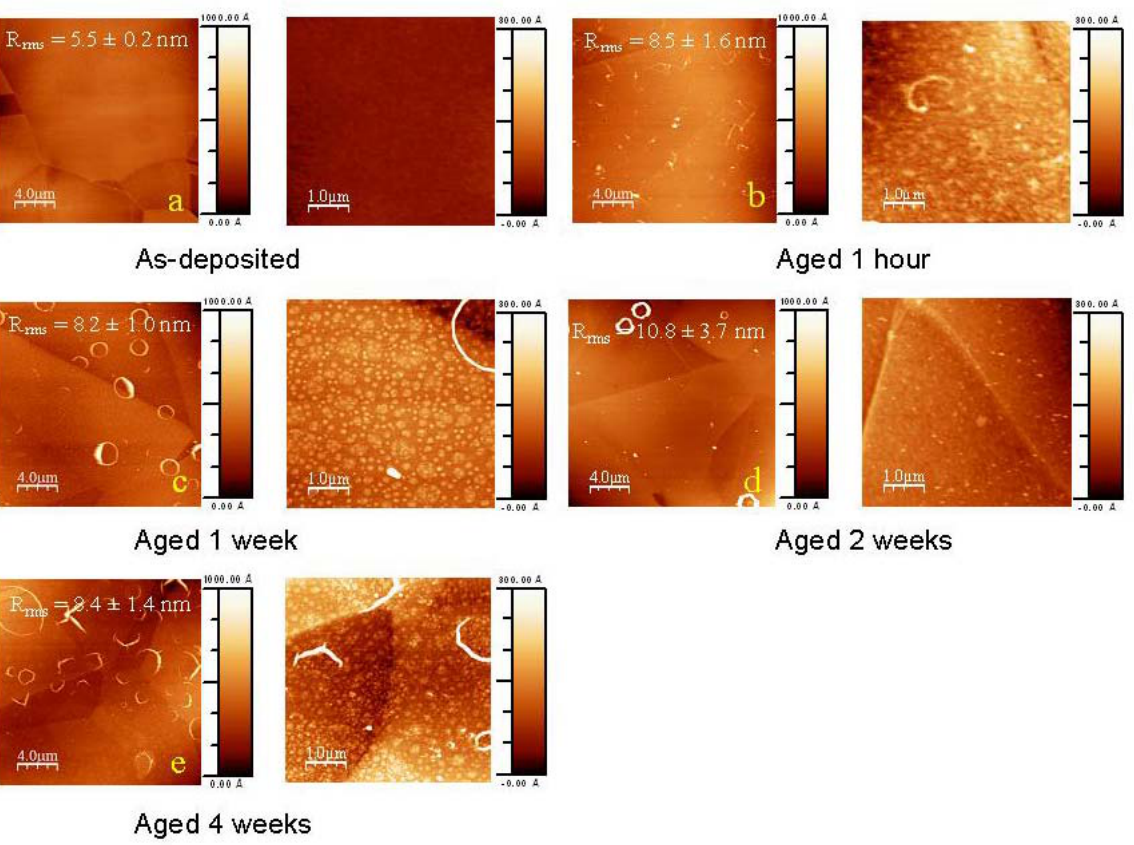
Figure 2. Tapping mode AFM micrographs for deformed samples at different time points of ageing: (a) as-deposited, (b) aged 2 weeks, (c) aged 4 weeks.